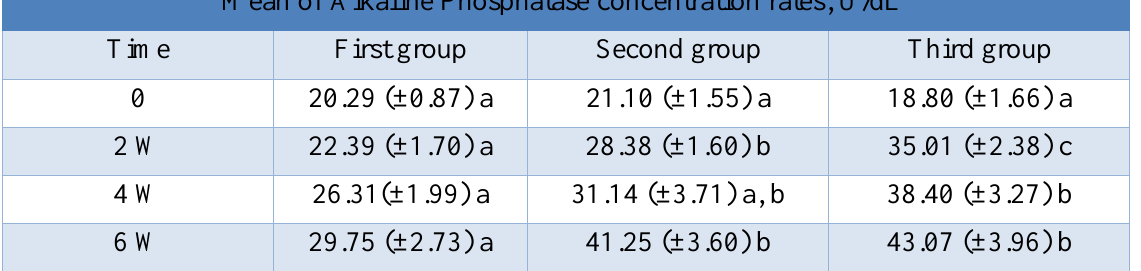
Table, 2: Show alkaline phosphatase enzyme concentration rates with its statistical analysis in the three main groups of